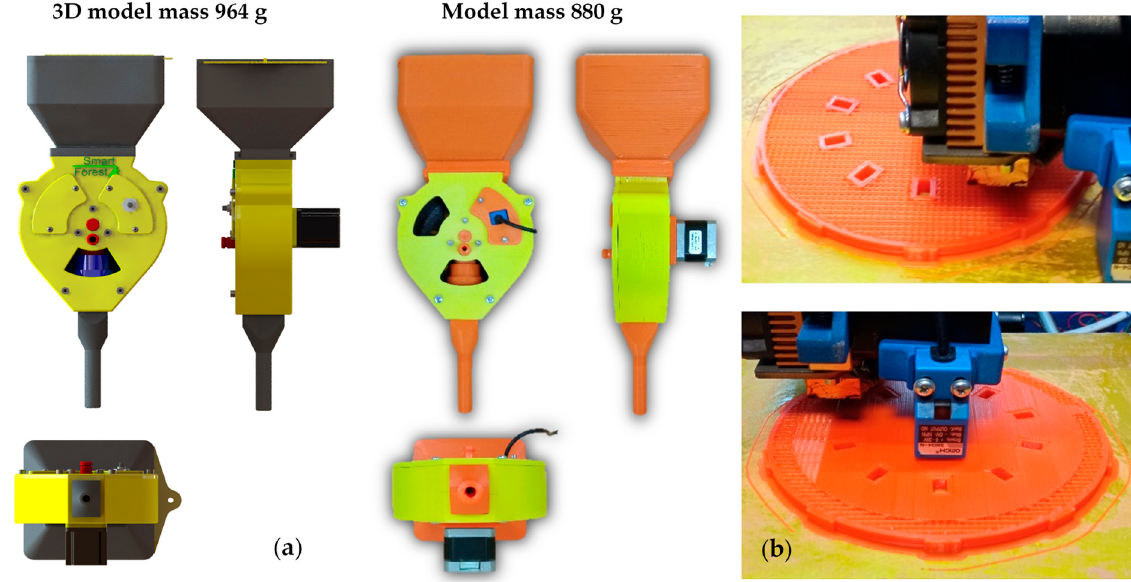
Figure 23. Experimental sowing device: ( a ) Comparison of mass with 3D model; ( b ) Production of a metering drum with partial filling.